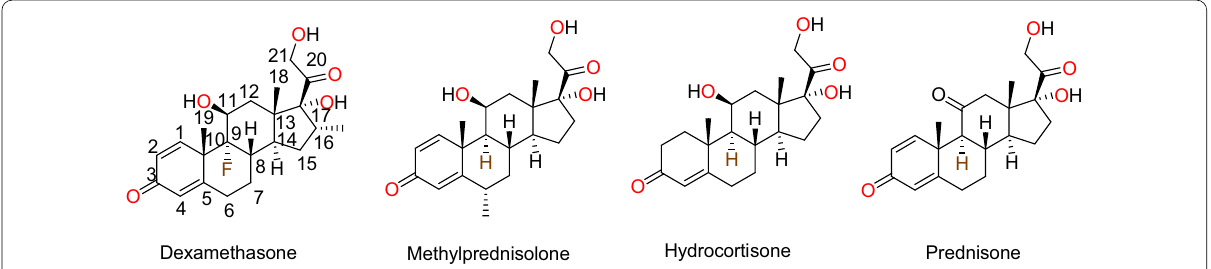
Fig. 1 Chemical structure of corticosteroids being evaluated as potential treatment of COVID-19